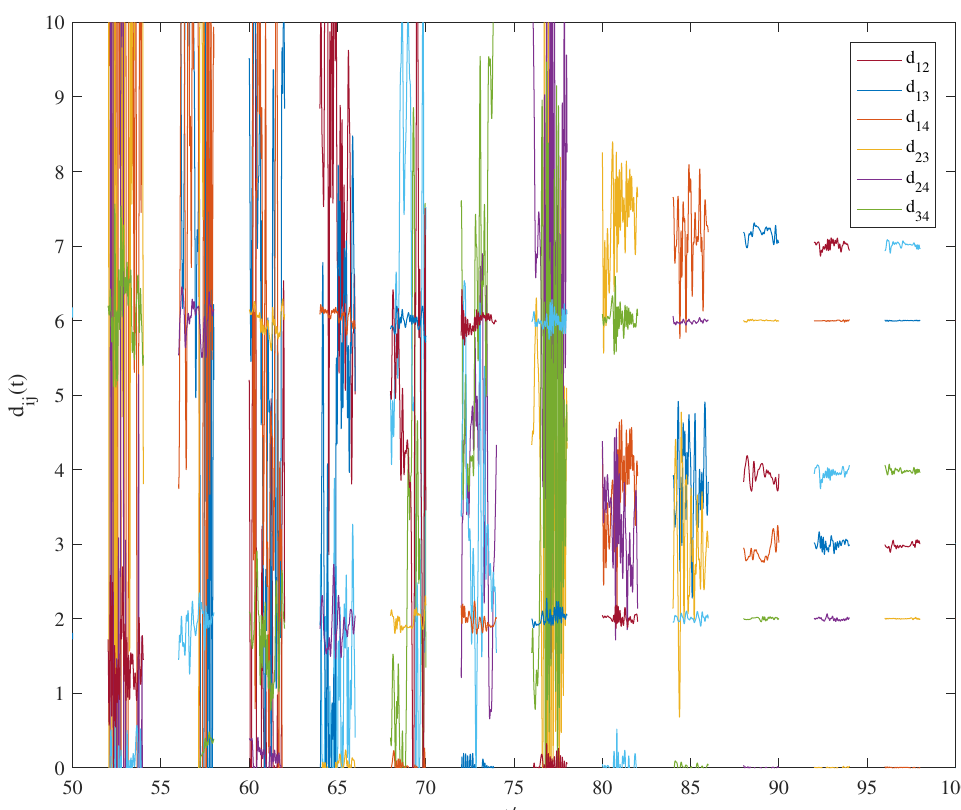
Figure 5. Topology identification for the dynamical network in Example